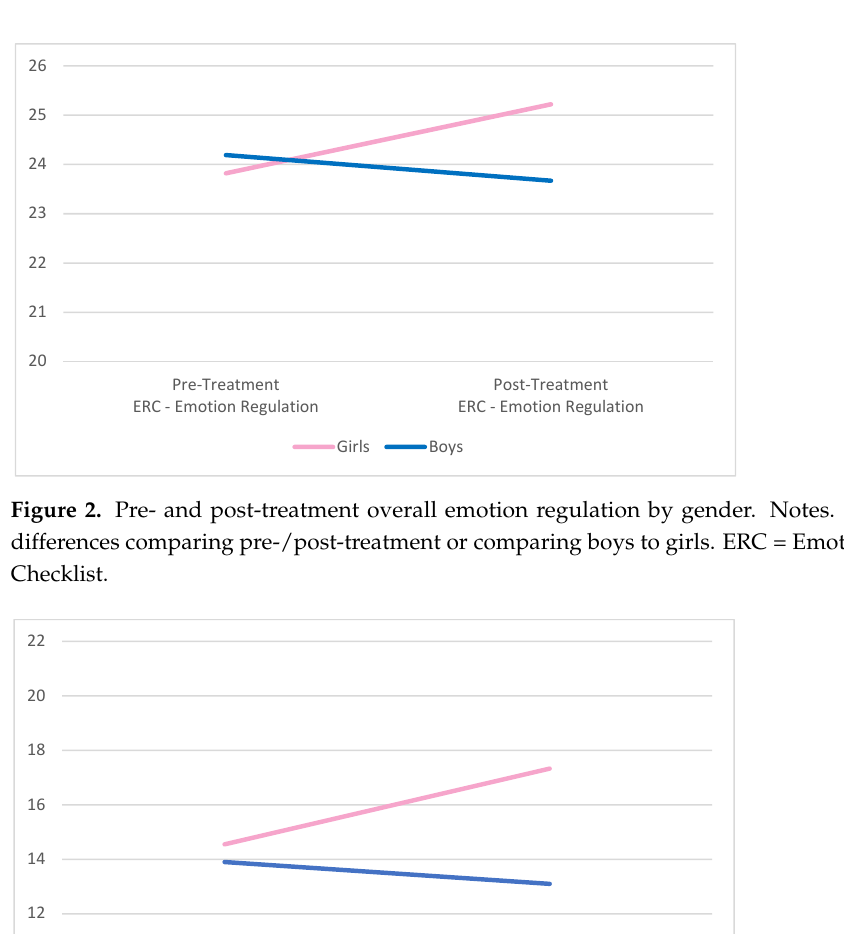
Figure 1. Pre- and post-treatment lability/negativity by gender. Notes. No significant differences comparing pre-/post-treatment or comparing boys to girls. ERC = Emotion Regulation Checklist.